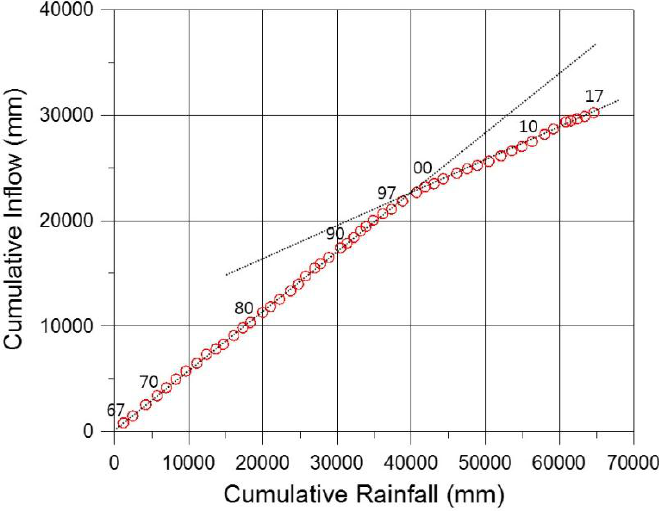
Figure 4. Double-mass curve to detect the change point.